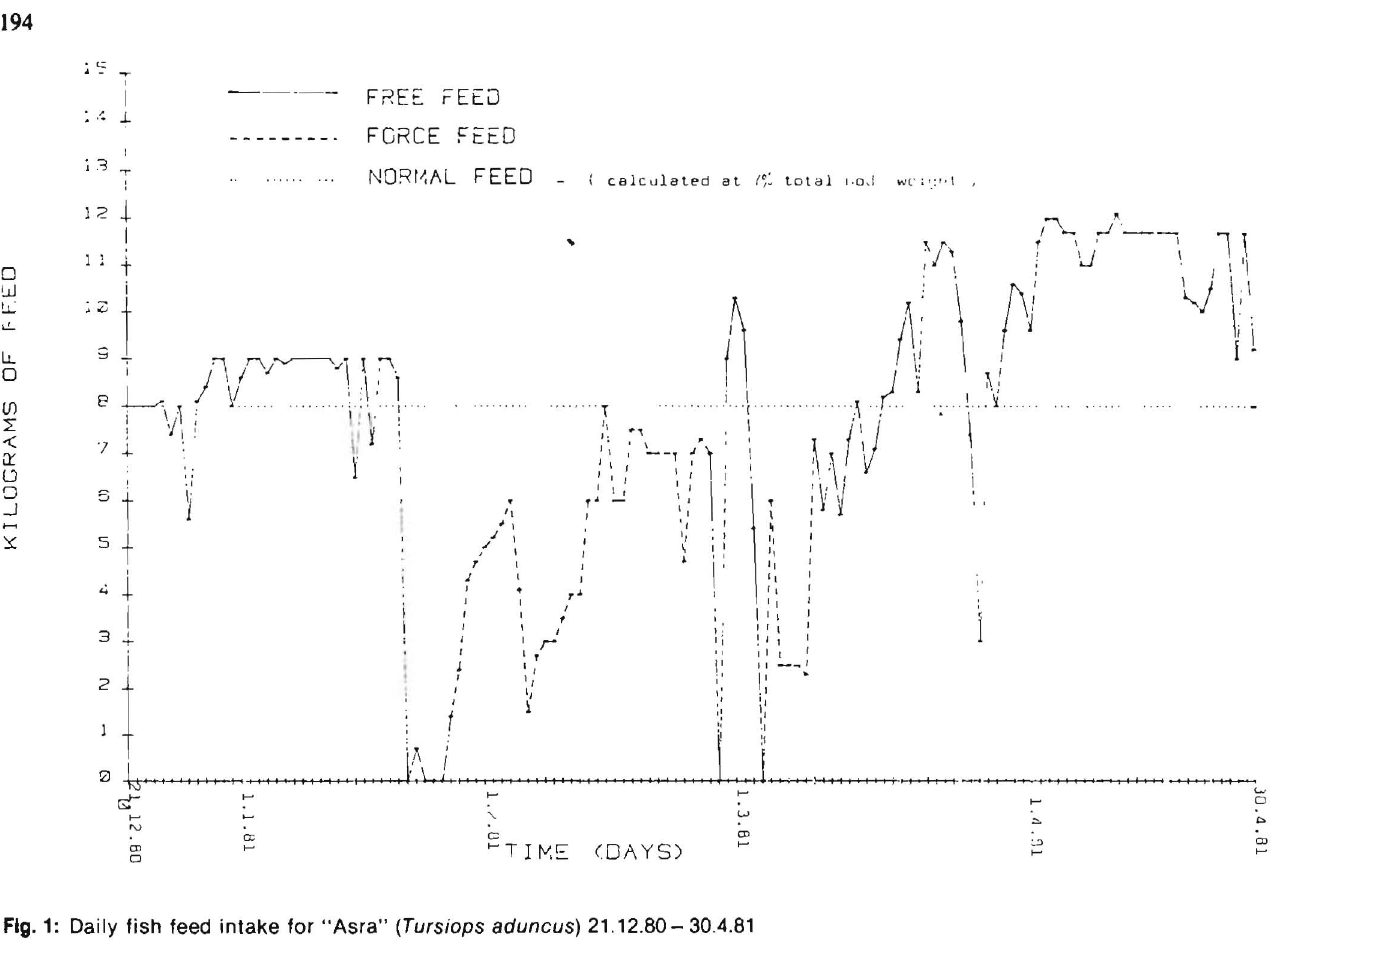
Fig. 1: Daily fish feed intake for "Asra" (Tursiops aduncus) 21.12.80 - 30.4.81